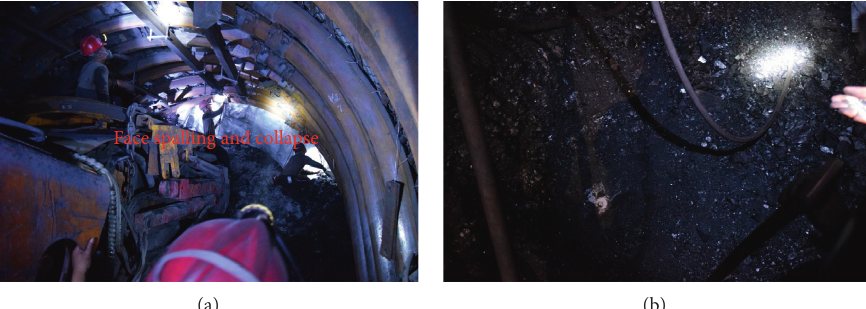
Figure 1: Field photos during the driving of roadway in soft coal mass. (a) Spalling and collapse at tunneling face. (b) The falling coal